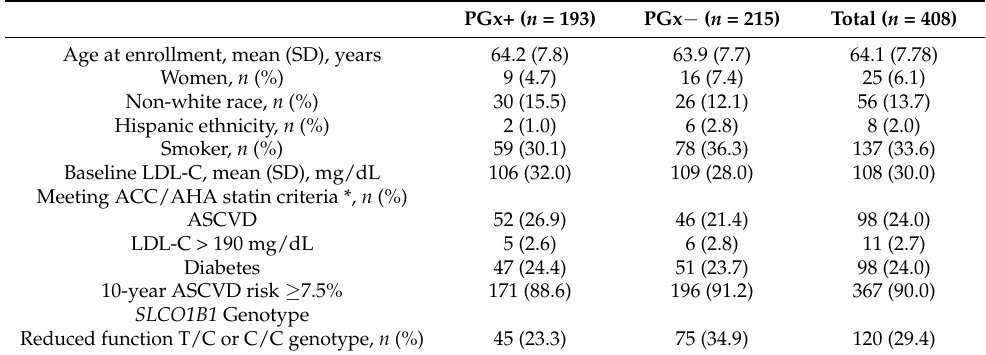
Table 1. Characteristics of trial